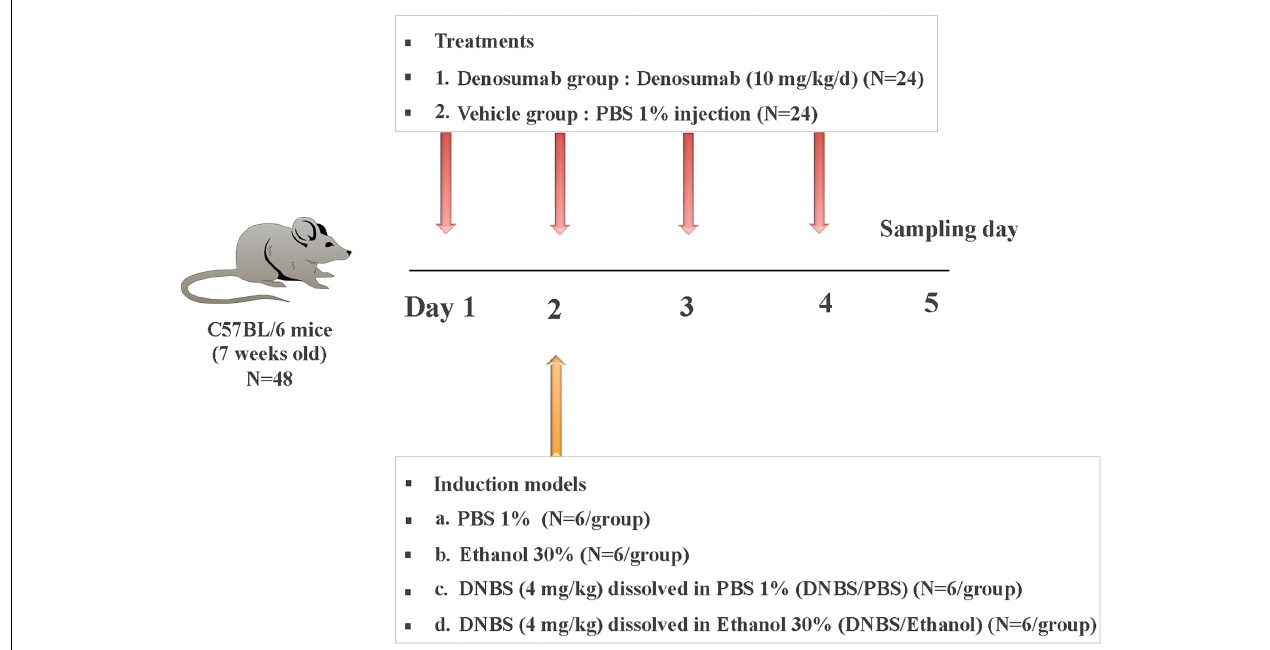
FIGURE 1 | Experimental design. Mice were treated with daily injection (i.p.) of PBS 1% (vehicle; n = 24) or denosumab ( n = 24) at 10 mg/kg/d for a total of 4 days. On day 2 of the experiment, mice were divided into four subgroups ( n = 6/subgroup) and subjected to different colitis induction models: (a) PBS 1%, (b)